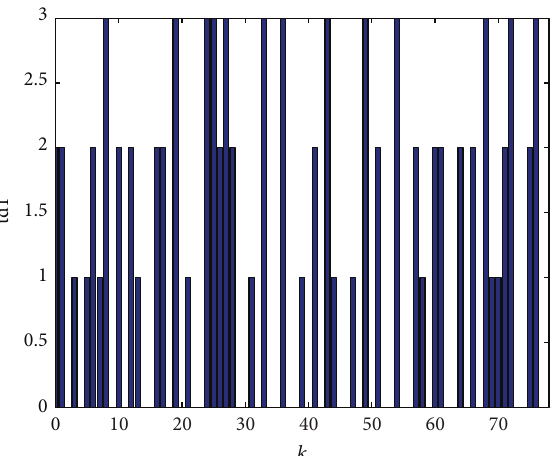
Figure 17: Bounded arbitrary time delays (Example 2).